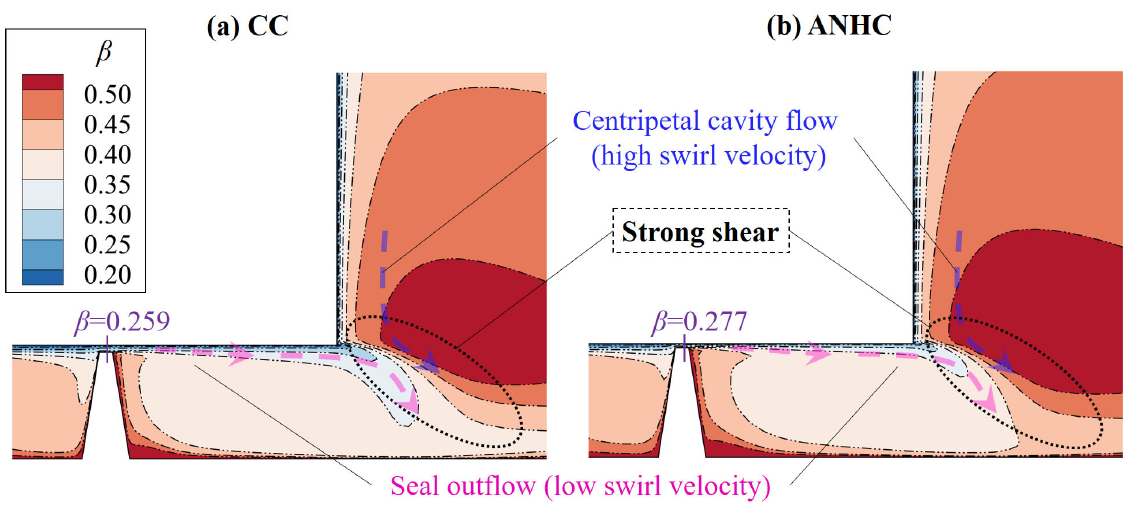
Figure 17. Swirl ratio contours around the entry of the rotor ‐ stator cavity (take ‐ off state). Moment coefficients of the rotating disk surface under CC and ANHC are compared in Figure 18. Affected by the inlet seal thermal deformation, the moment coefficients under the ANHC were lower than those under CC by 5–6% in the three hot-running states. It is well-known that the increase in the swirl ratio contributes to the reduction in the moment coefficient. A higher swirl ratio, meaning lower relative tangential velocity between the cooling air and rotating disk surface, results in less friction torque. Thus, the reduction of the moment coefficient in the case of the ANHC can be explained by the combined effect of the swirl ratio increase at the seal outlet and the flow coefficient decrease.